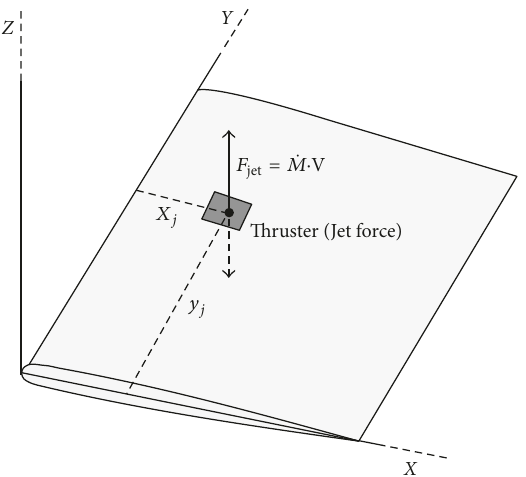
Figure 4: Three-dimensional perspective of the wing and the place- ment and operation of the thruster in up direction (symmetrically employed in down direction in appropriate